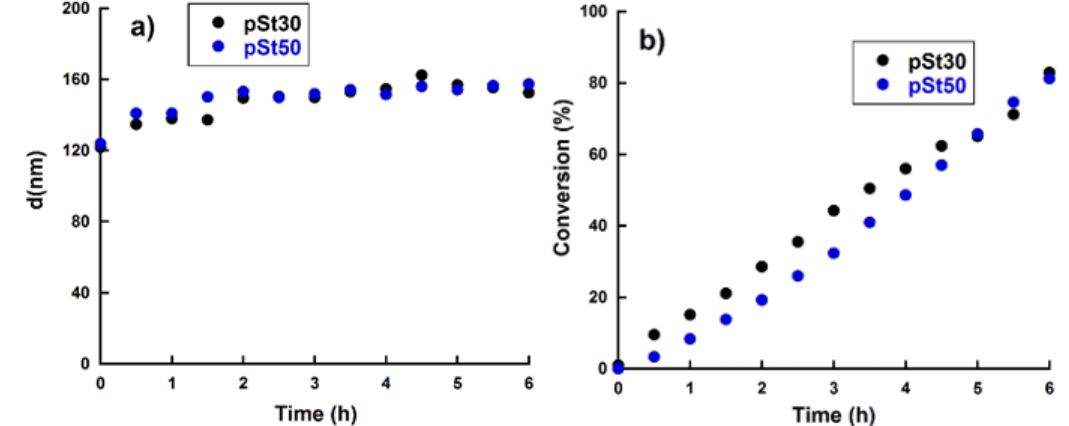
Figure 2. Evolution of ( a ) droplet/particle size evolution with time; ( b ) St conversion versus time for the miniemulsion polymerizations carried out to obtain pSt30 and pSt50.